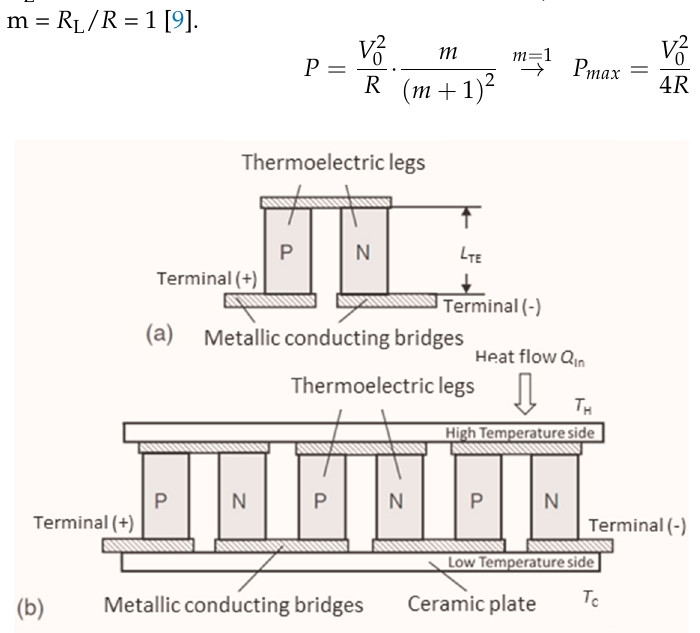
Figure 1. N- and p-type thermoelectric legs form a thermocouple ( a ). Multiple thermocouples can be connected electrically in series within a TEM ( b ). The TEM is operated between a heat source at the hot side temperature T H and a heat sink with a cold side temperature T C . The heat flow 𝑄(cid:4662) (cid:2893)(cid:2924) is partially converted into electric energy.